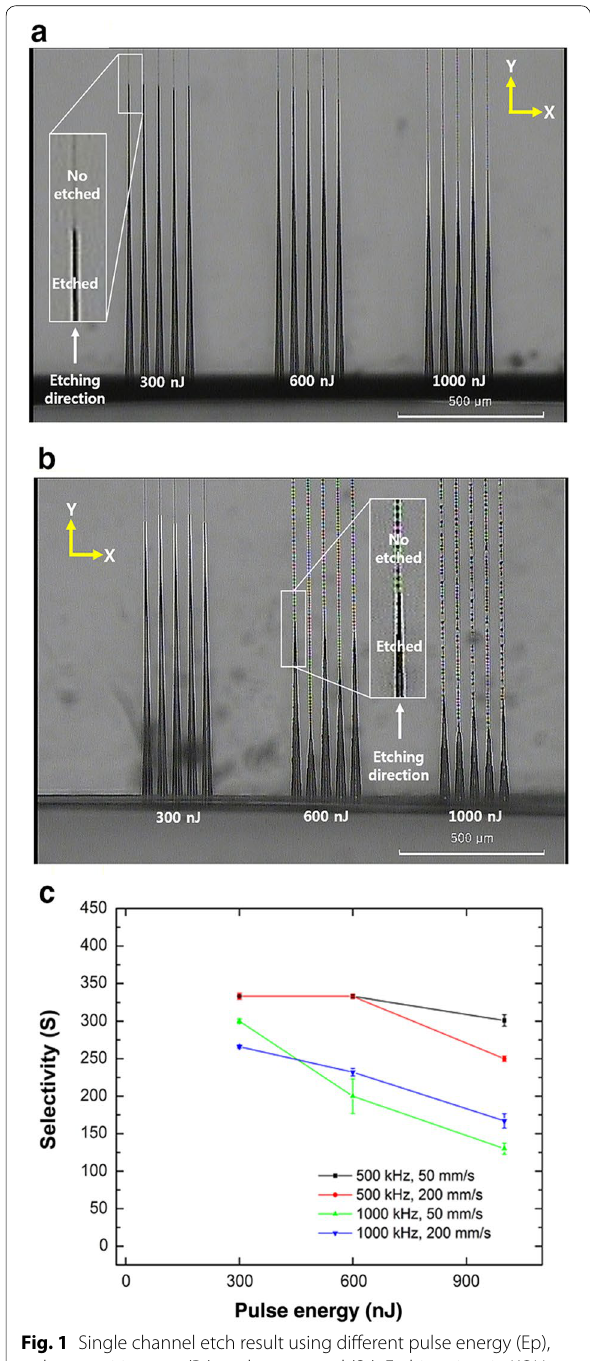
Fig. 1 Single channel etch result using different pulse energy (Ep), pulse repetition rate (Rr), and scan speed (Ss). Etching time in KOH was 6 h. Optical images of fabricated channels with Ep: 300 nJ, 600 nJ, 1000 nJ, Ss: 50 mm/s at different repetition rates a Rr: 500 kHz, and b Rr: 1000 kHz, c a graph of the selectivity according to various combinations of pulse energy, pulse repetition rate, and scan